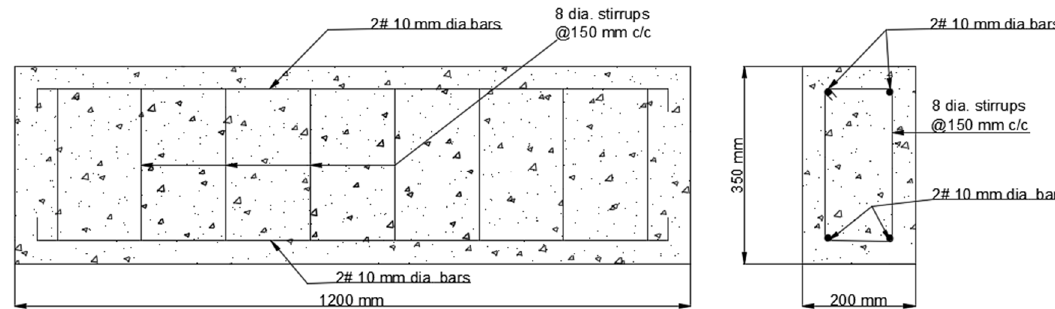
Figure 1. Reinforcement detail of beam.